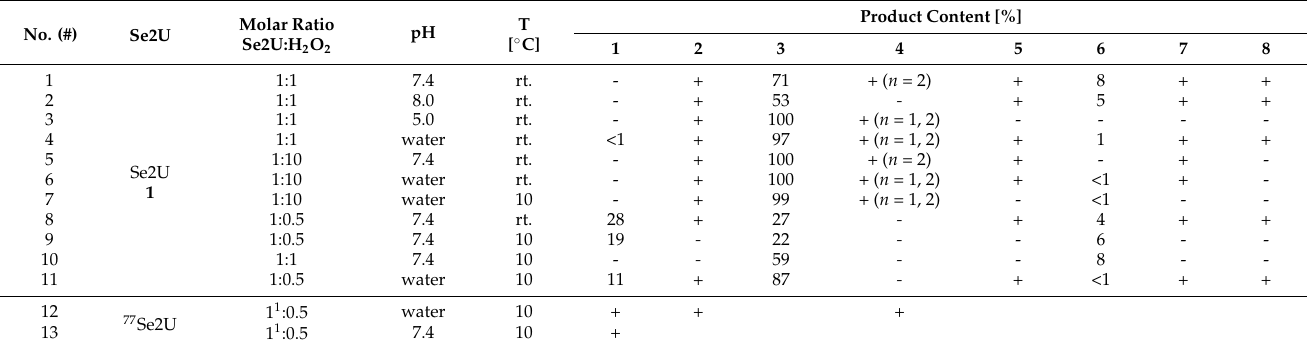
Table 1. Detailed listing of oxidation experiments for Se2U (#1-13), with the content of each reaction product (%). Reactions of Se2U (10 mM or otherwise defined in the footnote) with hydrogen peroxide in molar ratios of 1:1, 1:0.5, and 1:10 were carried out either in phosphate buffer pH 5.0, 7.4, and 8.0, water at room temperature (rt.), or at 10 ◦ C. The content of the reaction products was determined by integration of the 1 H NMR signals for the non-exchangeable H5, H6, and H1 (cid:48) protons ( δ